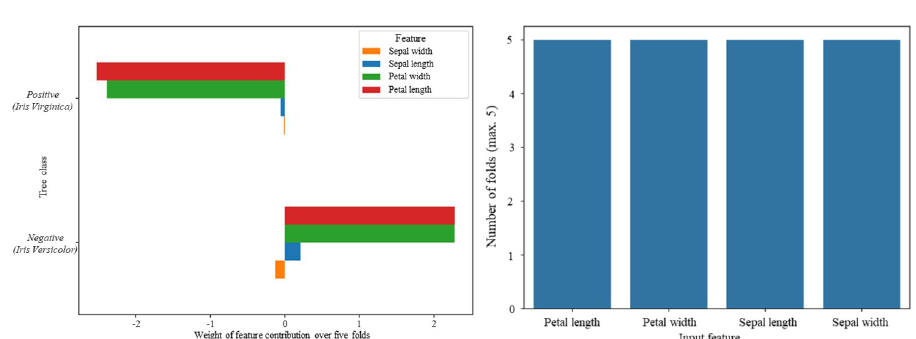
Fig 4. Average feature contributions and count number over 5-fold cross validation. (a) By investigating the five folds used for cross-validation shown in Table 3, we once again determined ‘petal width’ and ‘length’ to be the most important features for positive and negative classification within our decision tree. (b) A count of the number of folds each feature appeared in during the cross-validation process revealed that all four features appeared equally throughout the decision making process—suggesting that despite being significantly less important features for positive and negative classification than ‘petal length’ and ‘width’, sepal features are utilised equally regularly to make predictions within the model across multiple